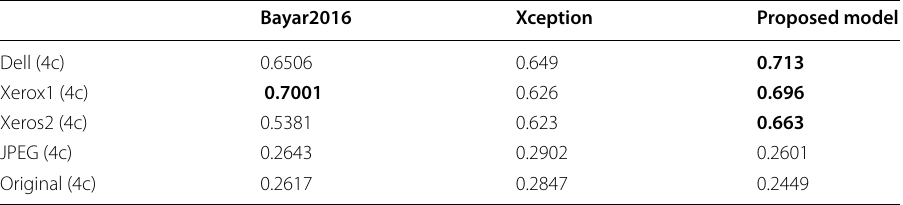
Table 5 Validation accuracy for various validation sets after training on the composite printers data set